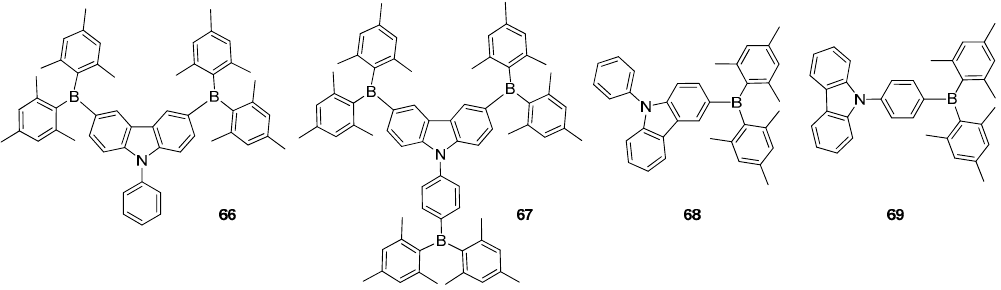
Figure 11. Triarylborane based phosphorescent materials 66 – 69 .